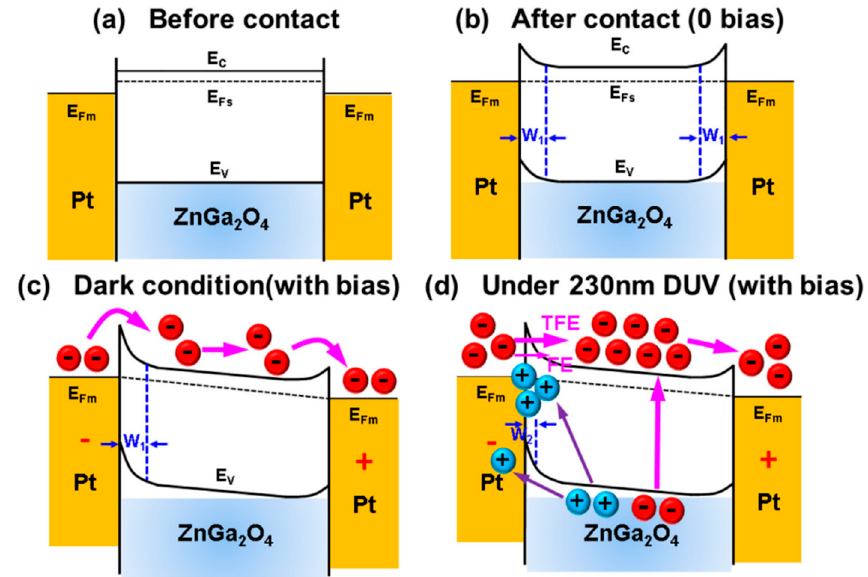
Figure 22. Energy-band diagram of metal-semiconductor-metal (MSM) structure ( a ) before metal contact, ( b ) after metal contact, ( c ) in dark conditions, and ( d ) under deep-ultraviolet (DUV) illumination [85] (with copyright permission from Elsevier, 2020).